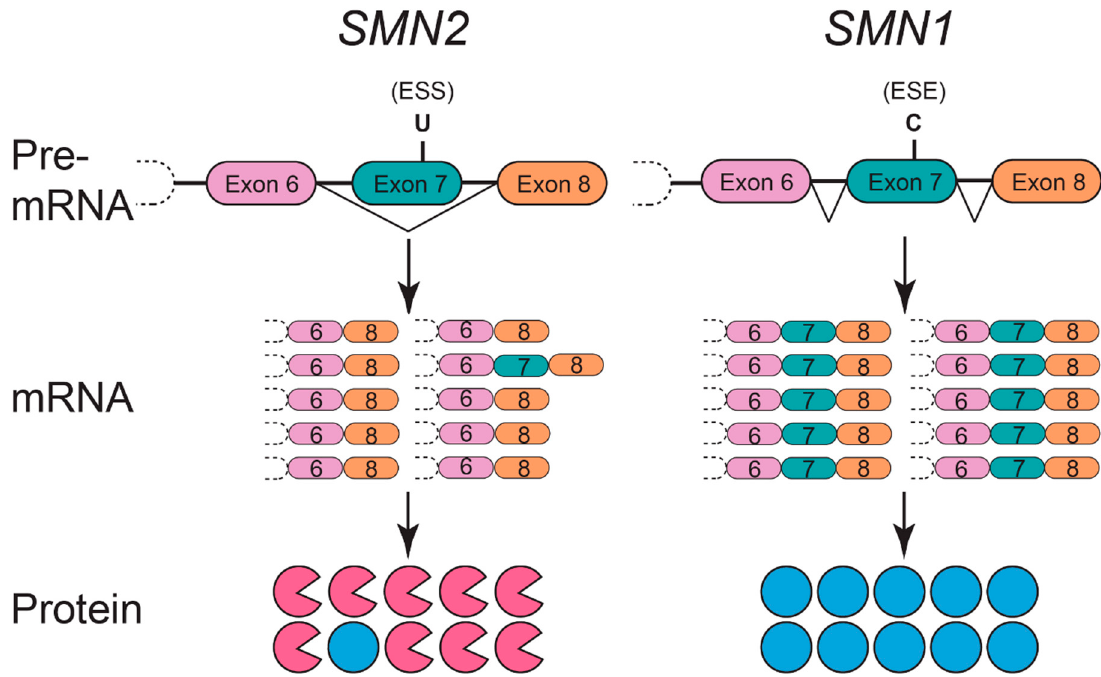
Figure 1. Differential pre ‐ mRNA splicing of SMN1 and SMN2 genes. The SMN1 gene (right) effectively splices exon 7 into the mature mRNA transcript, resulting in ~100% full ‐ length SMN protein (blue full circles). In contrast, a C to T nucleotide transition in exon 7 of the SMN2 gene (left; resulting in a U nucleotide in exon 7 pre ‐ mRNA) causes ~90% of the mature mRNA transcripts to lack exon 7 (pink incomplete circles). Without exon 7, the truncated protein (SMN Δ 7) is unstable, ineffective at oligomerization, and consequently degraded.